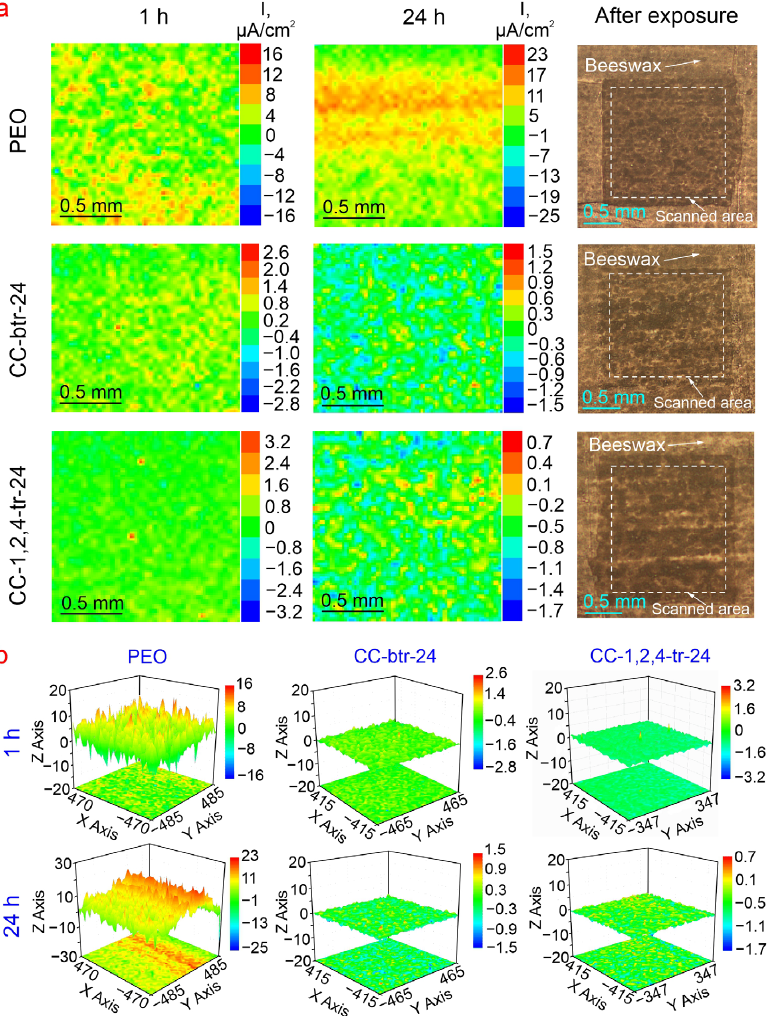
Figure 12. SVET maps (color scale depicts the local current density in µA cm 2 ) and optical images of scanned areas of samples with different types of coatings ( a ) and comparison of the intensity of samples ’ local electrochemical activity presented in 3D maps in PEO axis scale ( b ) .